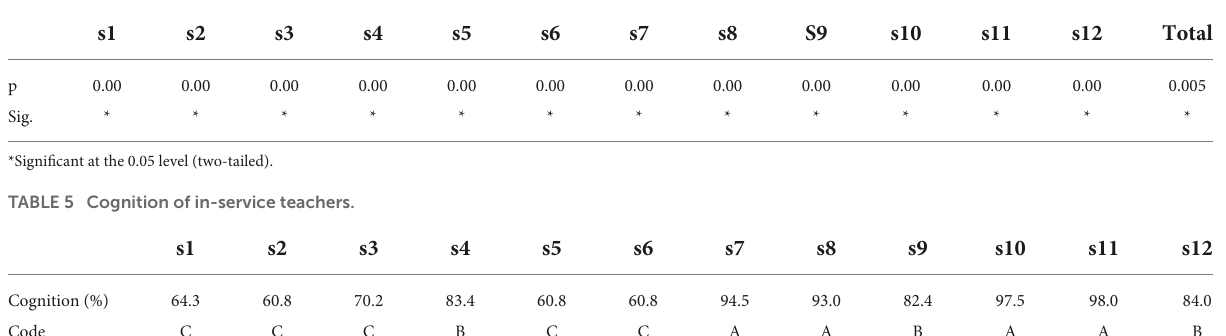
TABLE 4 One-sample Kolmogorov–Smirnov normality test.